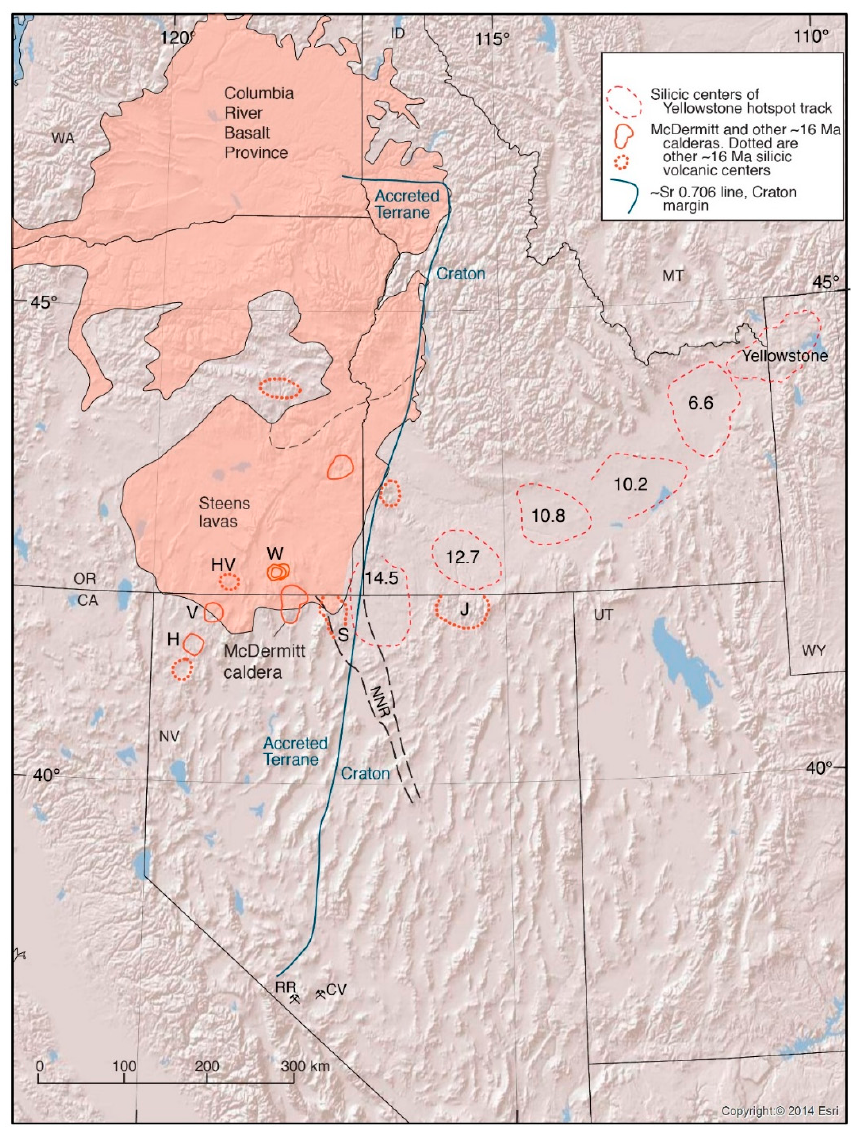
Figure 1. McDermitt caldera in relation to Yellowstone hotspot track (with volcanic centers and ages) and Columbia River Basalt Province. H: High Rock caldera; HV: Hawks Valley center; J: Jarbidge volcanic field; NNR: northern Nevada rift; S: Santa Rosa–Calico volcanic field; V: Virgin Valley caldera; W. Whitehorse and older calderas. RR: Rhyolite Ridge; CV: Clayton Valley. From [19–32]. CA—California; ID—Idaho; MT—Montana; NV—Nevada; OR—Oregon; UT—Utah; WA—Washington; WY—Wyoming.